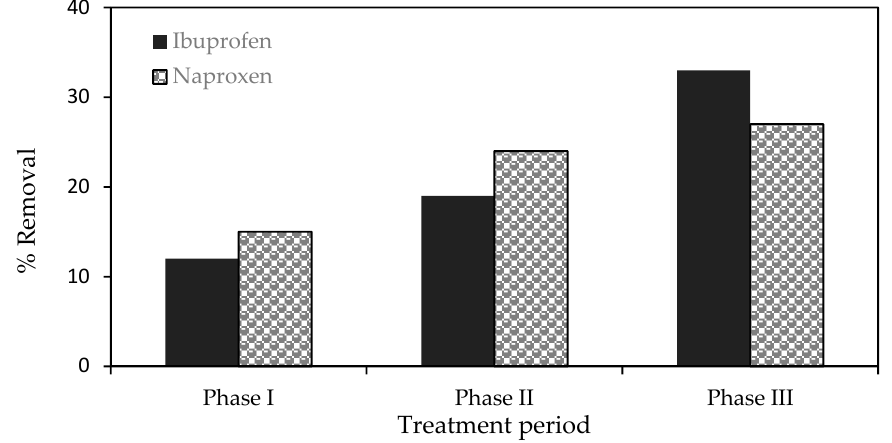
Figure 9. The final removal for naproxen and ibuprofen at the end of each treatment period.